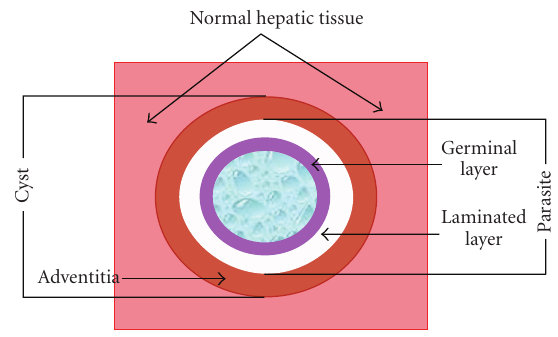
Figure 2: Hydatid cyst of the liver